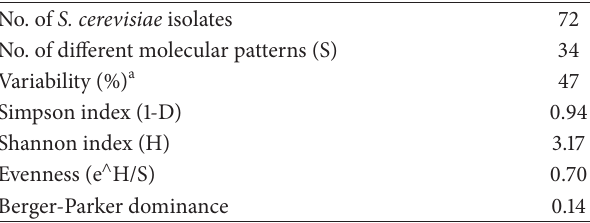
Table 1: Intraspecific diversity indices of S. cerevisiae population calculated from cluster